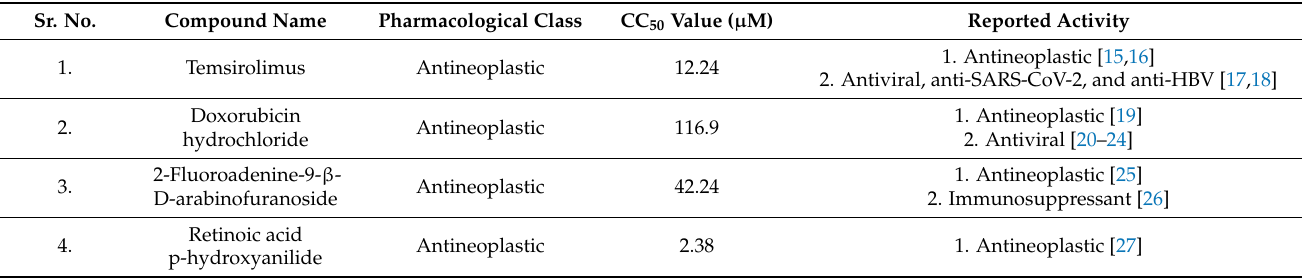
Table 1. Profile of the drugs repurposed as DENV-2